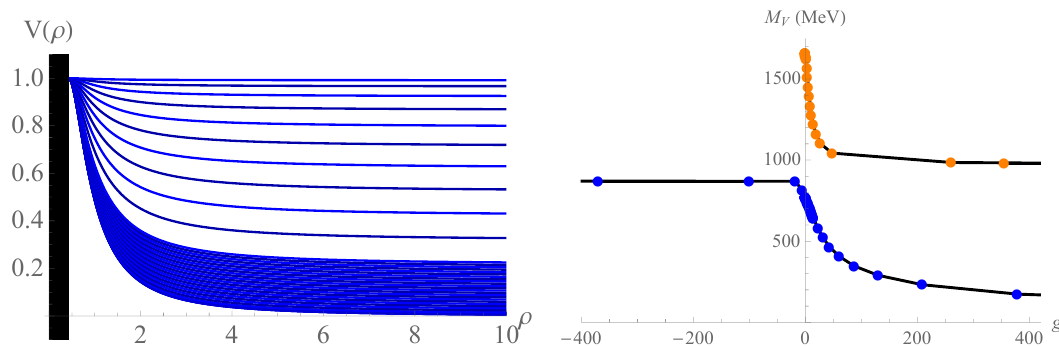
Figure 4. On the left the holographic wave functions of the vector meson ground state for various g 2 — the ground state at g 2 = 0 is the lowest curve; as M 2 decreases, g 2 increases and these are V V V the higher curves. The black region represents the region below the IR cut off ρ IR below which the quarks have become very massive and need to be integrated out. On the right we plot the associated masses against coupling g 2 extracted from those solutions — blue points are the ground V state (corresponding to the left hand points), the orange points are the first excited states.